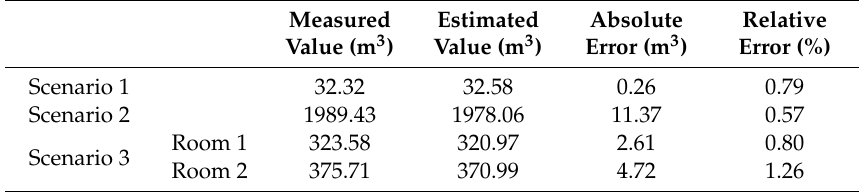
Table 5. Volume comparison between the estimated models and those manually